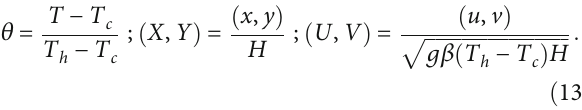
Figure 2: D2Q9 velocities.